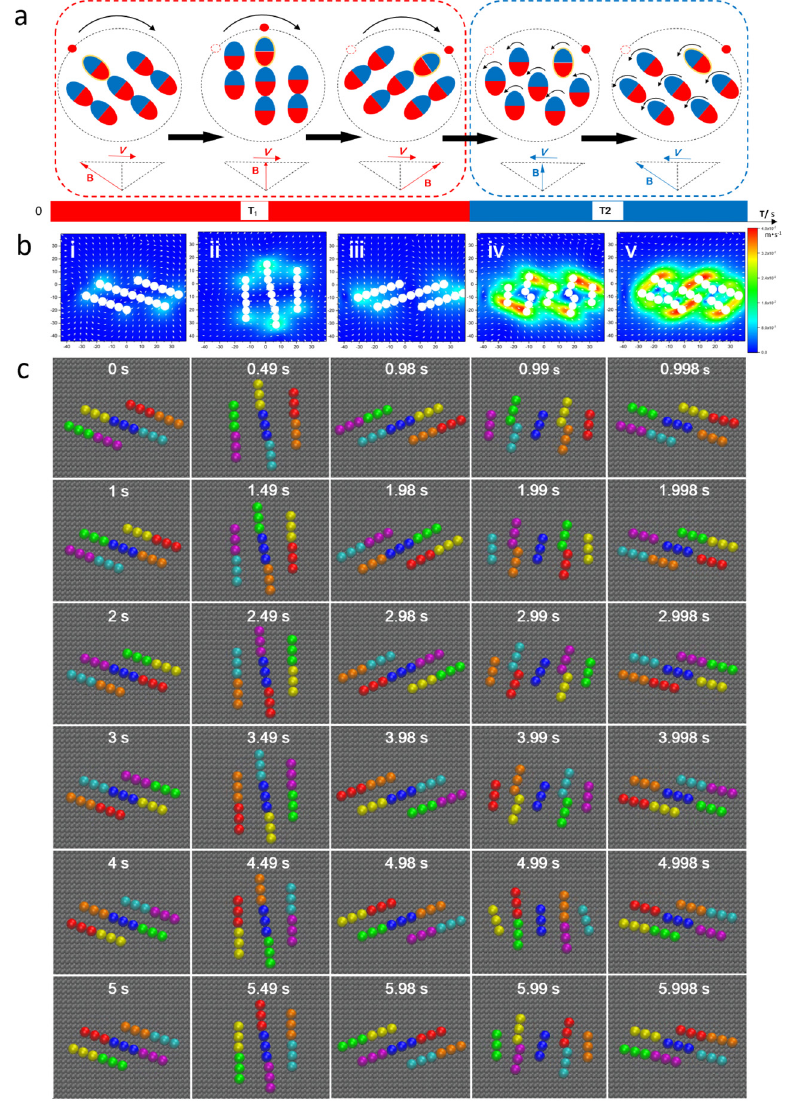
Figure 2. The formation mechanism analysis of a disk-like microswarm energized by a sawtooth magnetic field. ( a ) Schematic explanation of the rotary-stepping magnetic-chain mechanism. The ellipses represent tiny nanoparticle chains, and the parts in red and blue stand for the magnetic poles. ( b ) Simulation results of the flow field surrounding the magnetic chains actuated by a synthetic magnetic field with an amplitude ratio of γ = 3 and a frequency of f = 1 Hz. In stage T 1 , figures i–iii show the flow field with low velocity. Then, trimers rotate separately in stage T 2 , velocity in figures iv–v is much higher. ( c ) Dynamic sequence profile of a disk-like microswarm under a synthetic magnetic field. Trimers in diverse colors indicate different tiny magnetic chains.